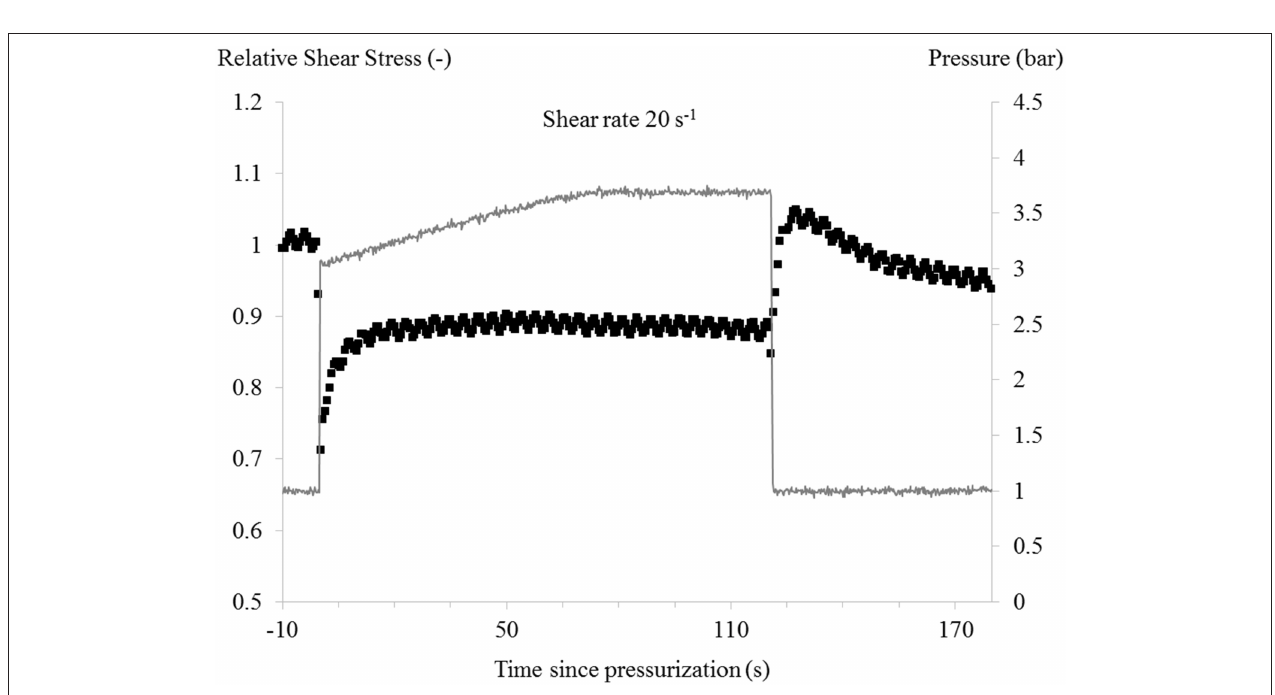
FIGURE 12 | Rate of air dissolution and reappearance at a shear rate of 20 s − 1 .